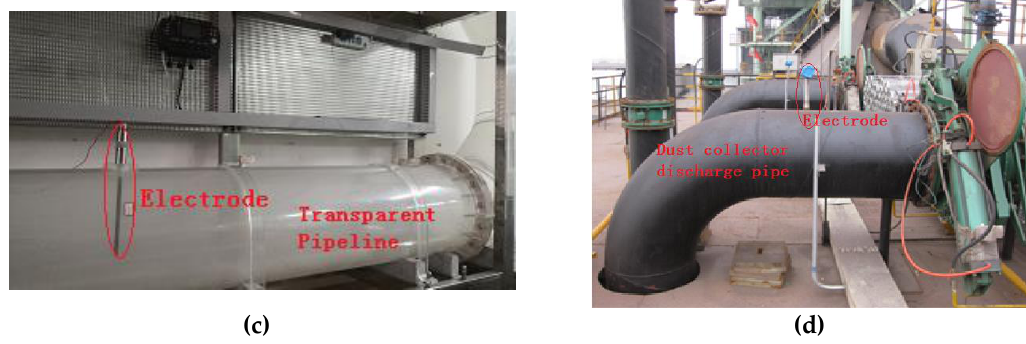
Figure 1. Working principle figure of the electrode and its application: ( a ) Schematic figure; ( b ) in the